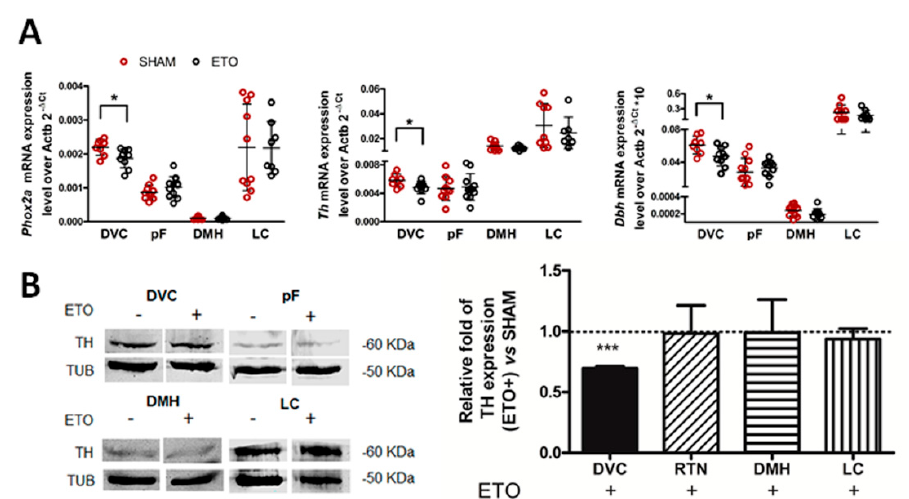
Figure 4. ETO reduces the expression of PHOX2B target genes in DVC. ( A ) qPCR analysis of Phox2a , Th and Dbh mRNA expression normalised to the endogenous standard Actb after 4 weeks ETO (black empty dots)/SHAM (red empty dots) treatment in the brain regions of interest. Data are expressed as 2 −Δ Ct and each data point represents one rat measurement; black horizontal lines correspond to the mean values. ( B ) Representative Western blot analysis and quantification of the effect of ETO on TH protein expression. Left: expression of TH and TUB in NTS, pF, DMH and LC in SHAM (ETO-) treated (ETO+) rats. Right: TH protein expression quantification relative to TUB in ETO-treated samples (black bars) relative to SHAM (mean values ± SD)., Significant differences in Phox2a , Th and Dbh mRNA expression and TH protein expression between SHAM and ETO-treated rats were observed only in DVC area (* p < 0.05 and *** p < 0.001, Student’s t -test).